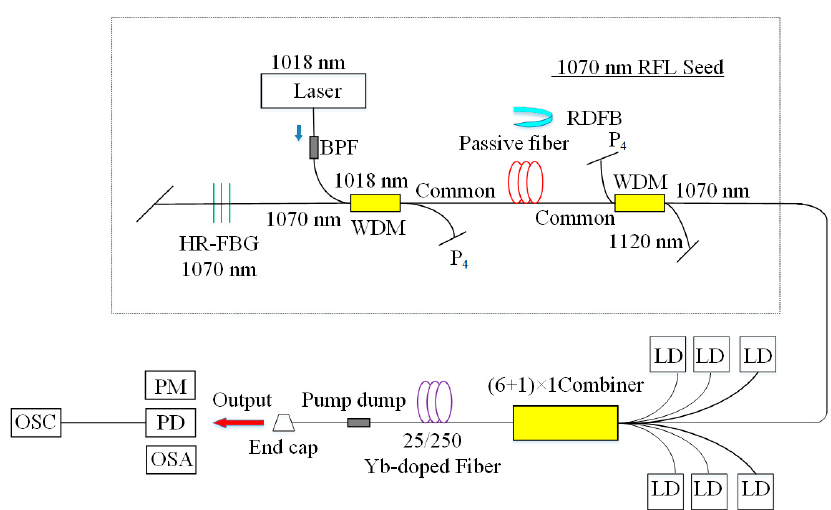
Figure 10. The scheme of RFL pumped by an amplified spontaneous emission (ASE) source.